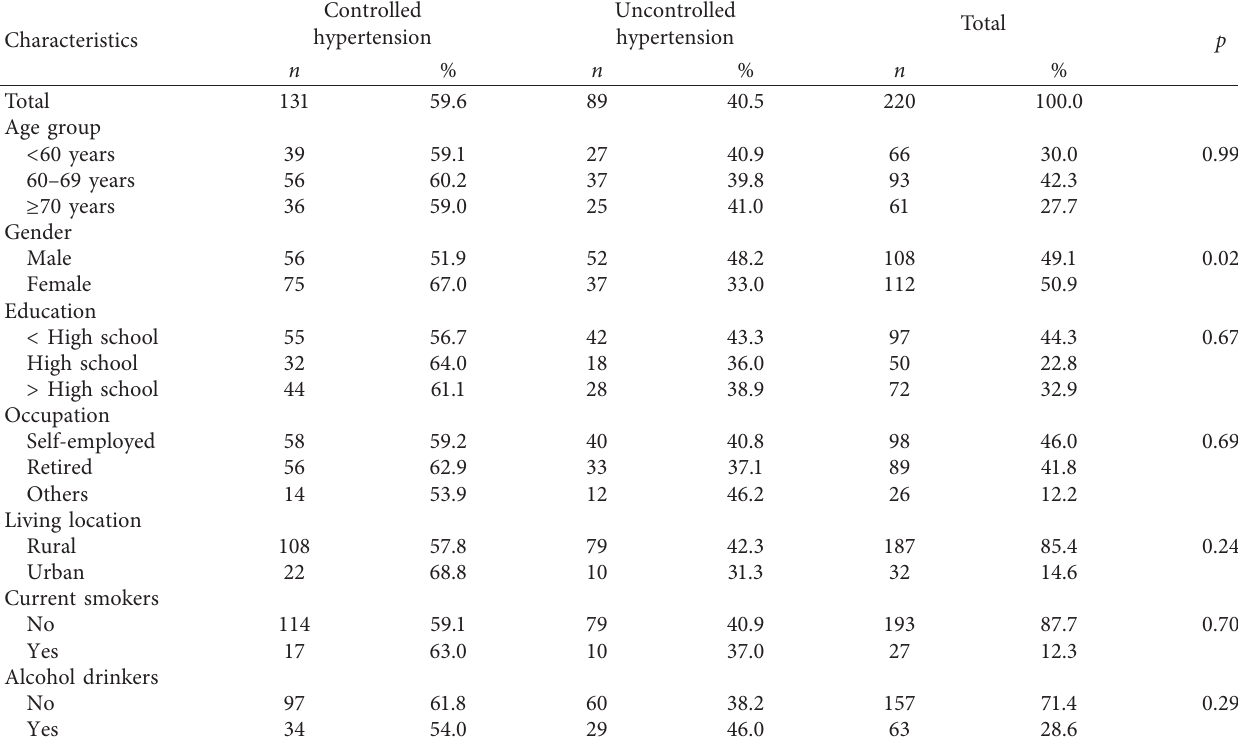
Table 1: Sociodemographic characteristics of hypertensive